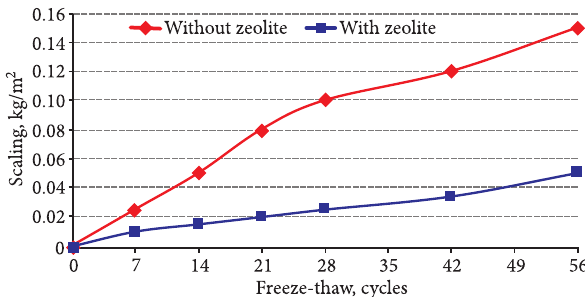
Fig. 9. Scaling of paving blocks after 56 freeze-thaw cycles according to LST EN 1338/AC Annex D